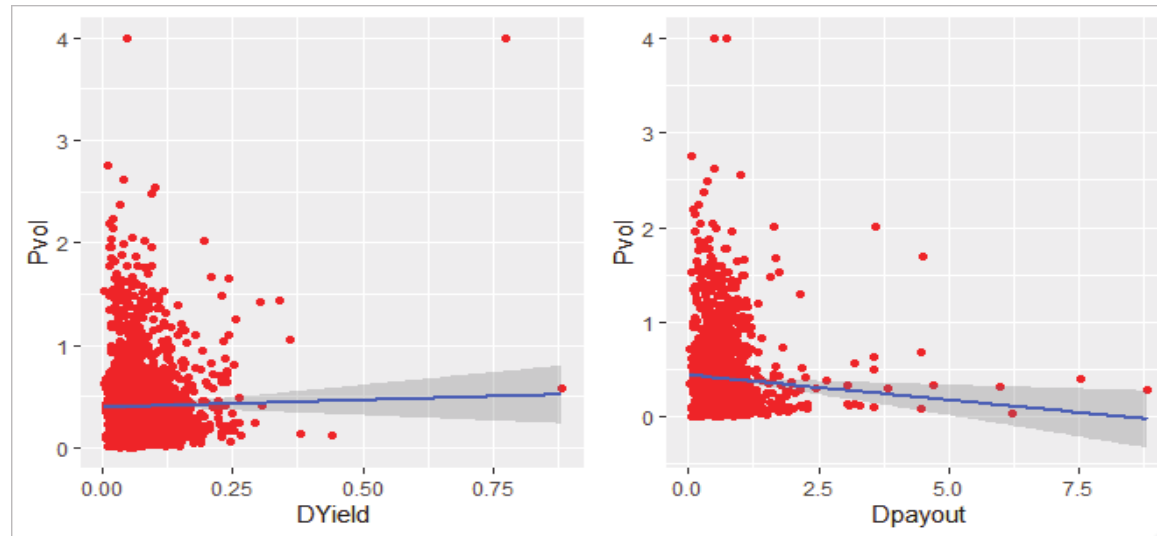
Fig. 2 . The relationship DYield, DPayout and